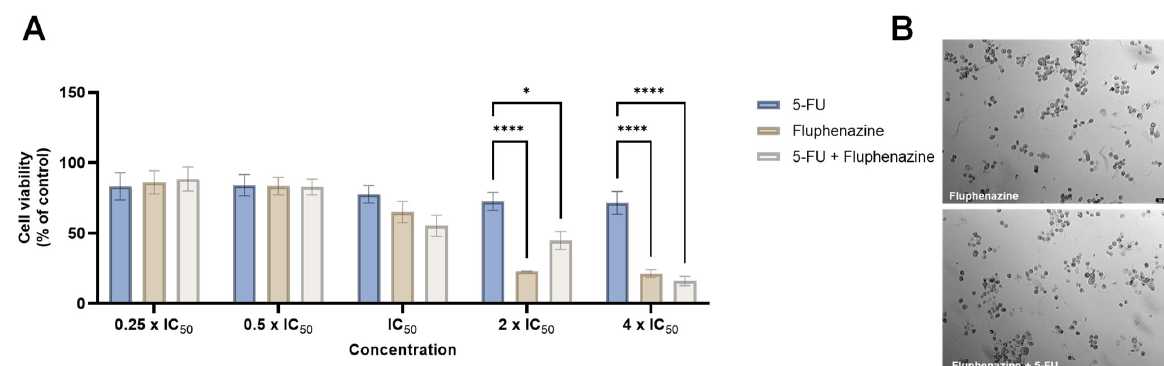
Figure 5. MTT results ( A ) and morphological analysis ( B ) of HT ‐ 29 cells treated for 48 h with a combination therapy of 5 ‐ FU and fluphenazine. Results are expressed in relation to control cells (treated with vehicle) and represent mean ± SEM. Each experiment was repeated three times ( n = 3); * statistically significant vs. control at p < 0.05. **** Statistically significant vs. control at p < 0.0001. Scale bar: 50 μ m. Adapted from [34].